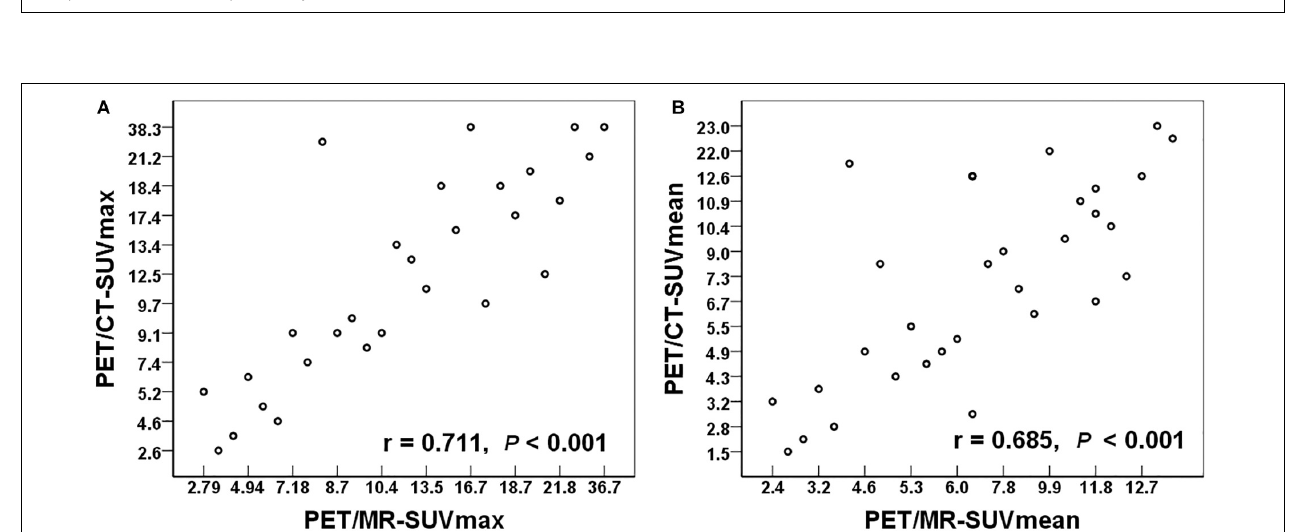
FIGURE 4 | (A) The relationship of the SUVmax between PET/MR and PET/CT. (B) The relationship of the SUVmean between PET/MR and PET/CT. SUVmax, maximum standardized uptake value; SUVmean, mean standardized uptake value.